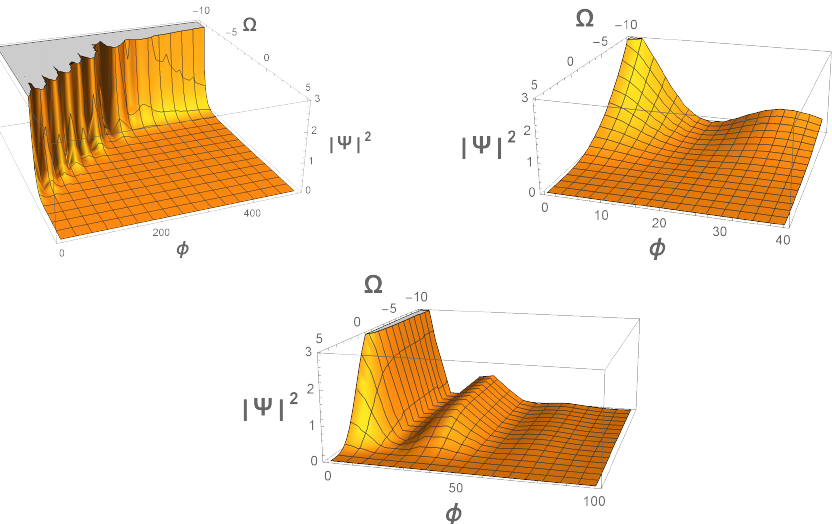
Figure 2. In the radiation-like era, we plot different combinations of the Equation (48), considering different values in the order parameter Q = − 1,0,1, from top to bottom, respectively. We consider the value for the parameter µ = 0.5; we discard other values in the Q